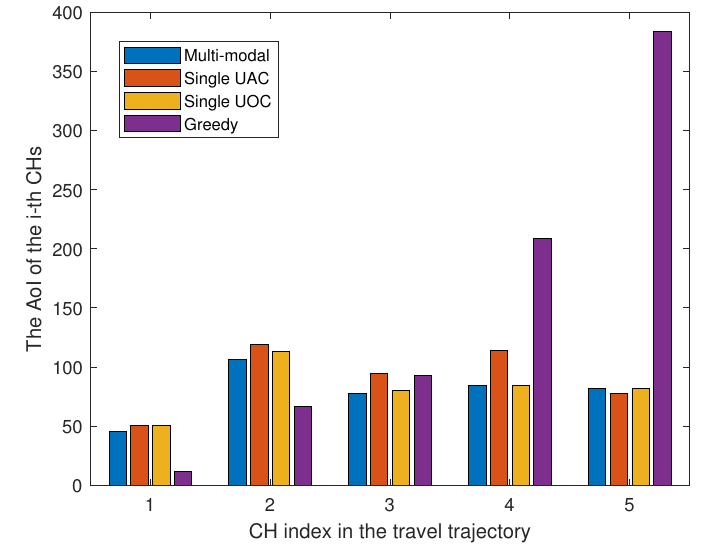
Figure 8. AoI for different paths when the number of CHs is